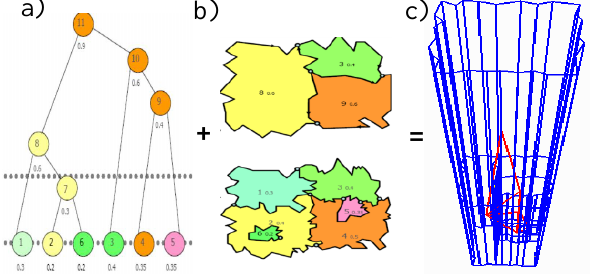
Fig.8. The idea on implementing the DHE vario-scale data